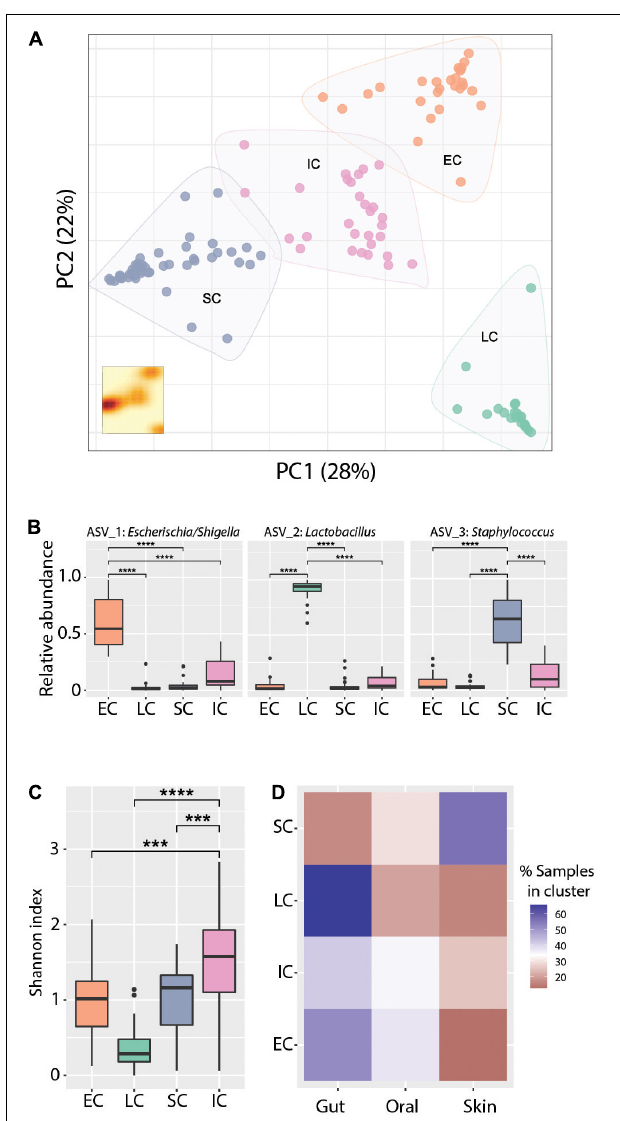
FIGURE 4 | Cluster analysis reveals distinct community states. (A) Principal coordinates analysis ordination of Bray-Curtis dissimilarities. K-means clustering analysis indicates four community types based on Silhouette score - Calinski harabasz maximization. KDE plot (bottom right) displays sample density on the first two principal components. (B) Relative abundance of the dominant ASVs in the respective clusters, Wilcoxon Rank-sum test **** p -value < 0.0001. (C) Alpha diversity measured with the Shannon index across community types. Wilcoxon Rank-sum test *** p -value < 0.001, **** p -value < 0.0001. (D) Representation of community types (clusters) in the gut, skin, and oral cavity respectively, as percentage of the total number of samples assigned to each cluster. Blue and red color gradients indicate positive or negative deviation, respectively, from a uniform cluster distribution across body sites (i.e.,